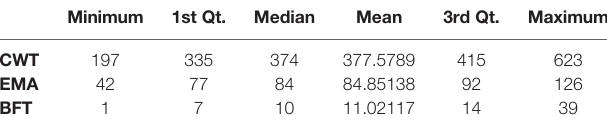
TABLE 1 | Summary statistics of the phenotypes used for the study. Minimum 1st Qt.